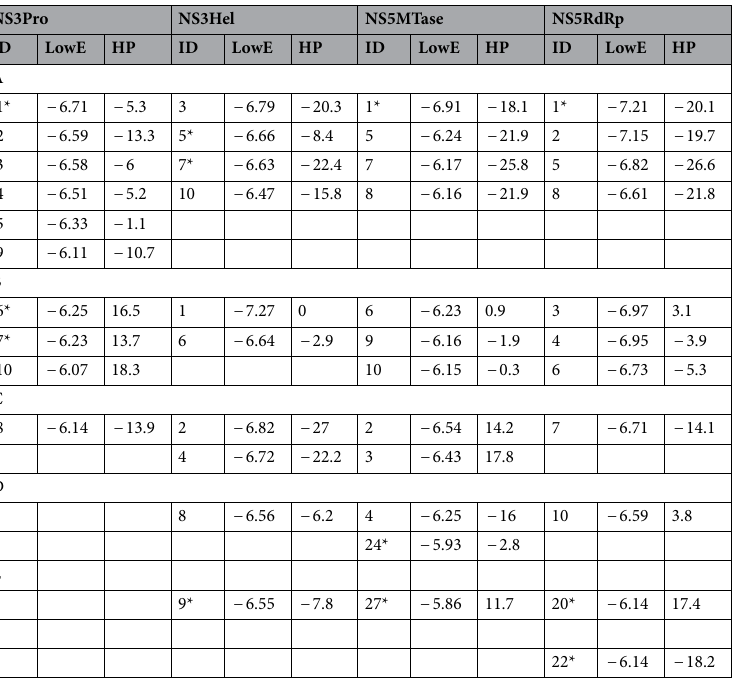
Table 2. The docked melatonin coordinates on JEV replication enzymes. Note ID, Nomenclature for docking poses; LowE, Docking energy (kcal/mol); HP, Hydrophobicity of groove interacting to an individual docked melatonin; the asterisk above ID names refers to the top 3 highest-number-in-cluster